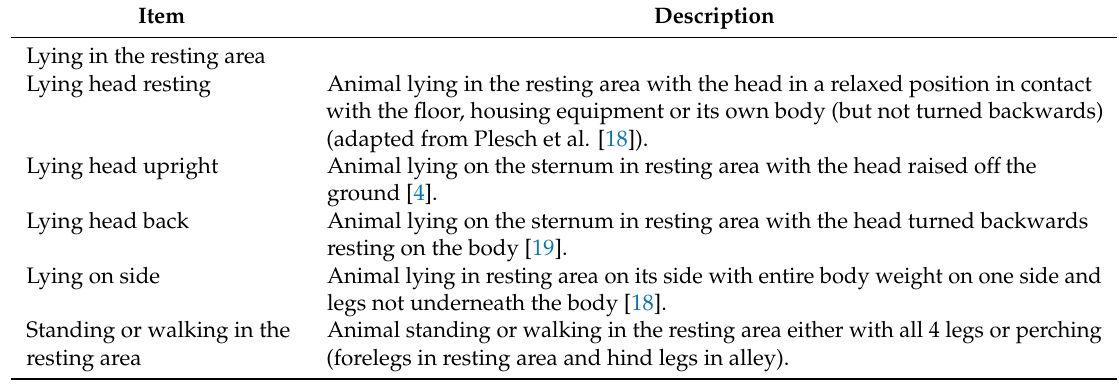
Table 4. Ethogram of behaviors assessed by scan sampling at 5-min intervals over two 3h